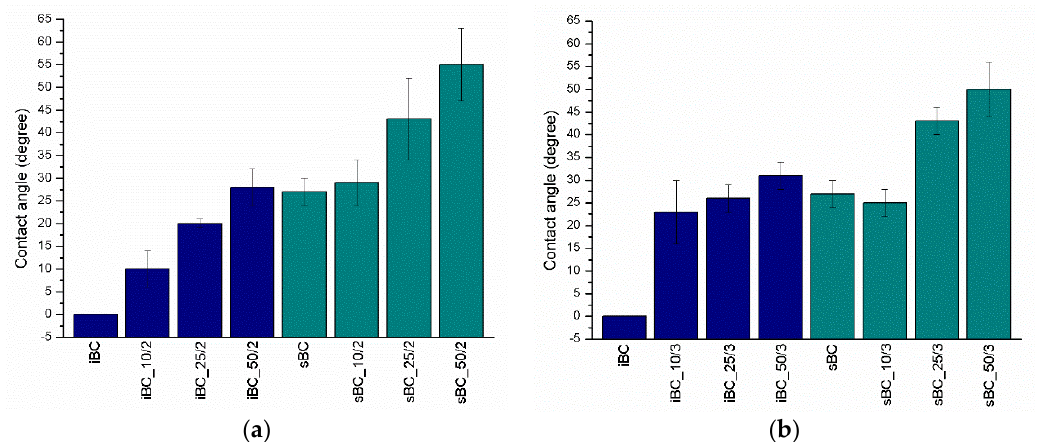
Figure 13. Contact angle of BC and GO/BC nanocomposite with two GO loadings ( a ) and three GO loadings ( b ).